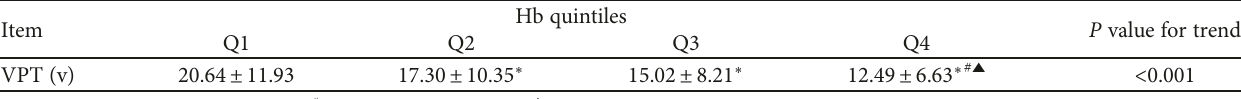
Table 3: Comparison across quartiles of Hb in all T2DM patients.